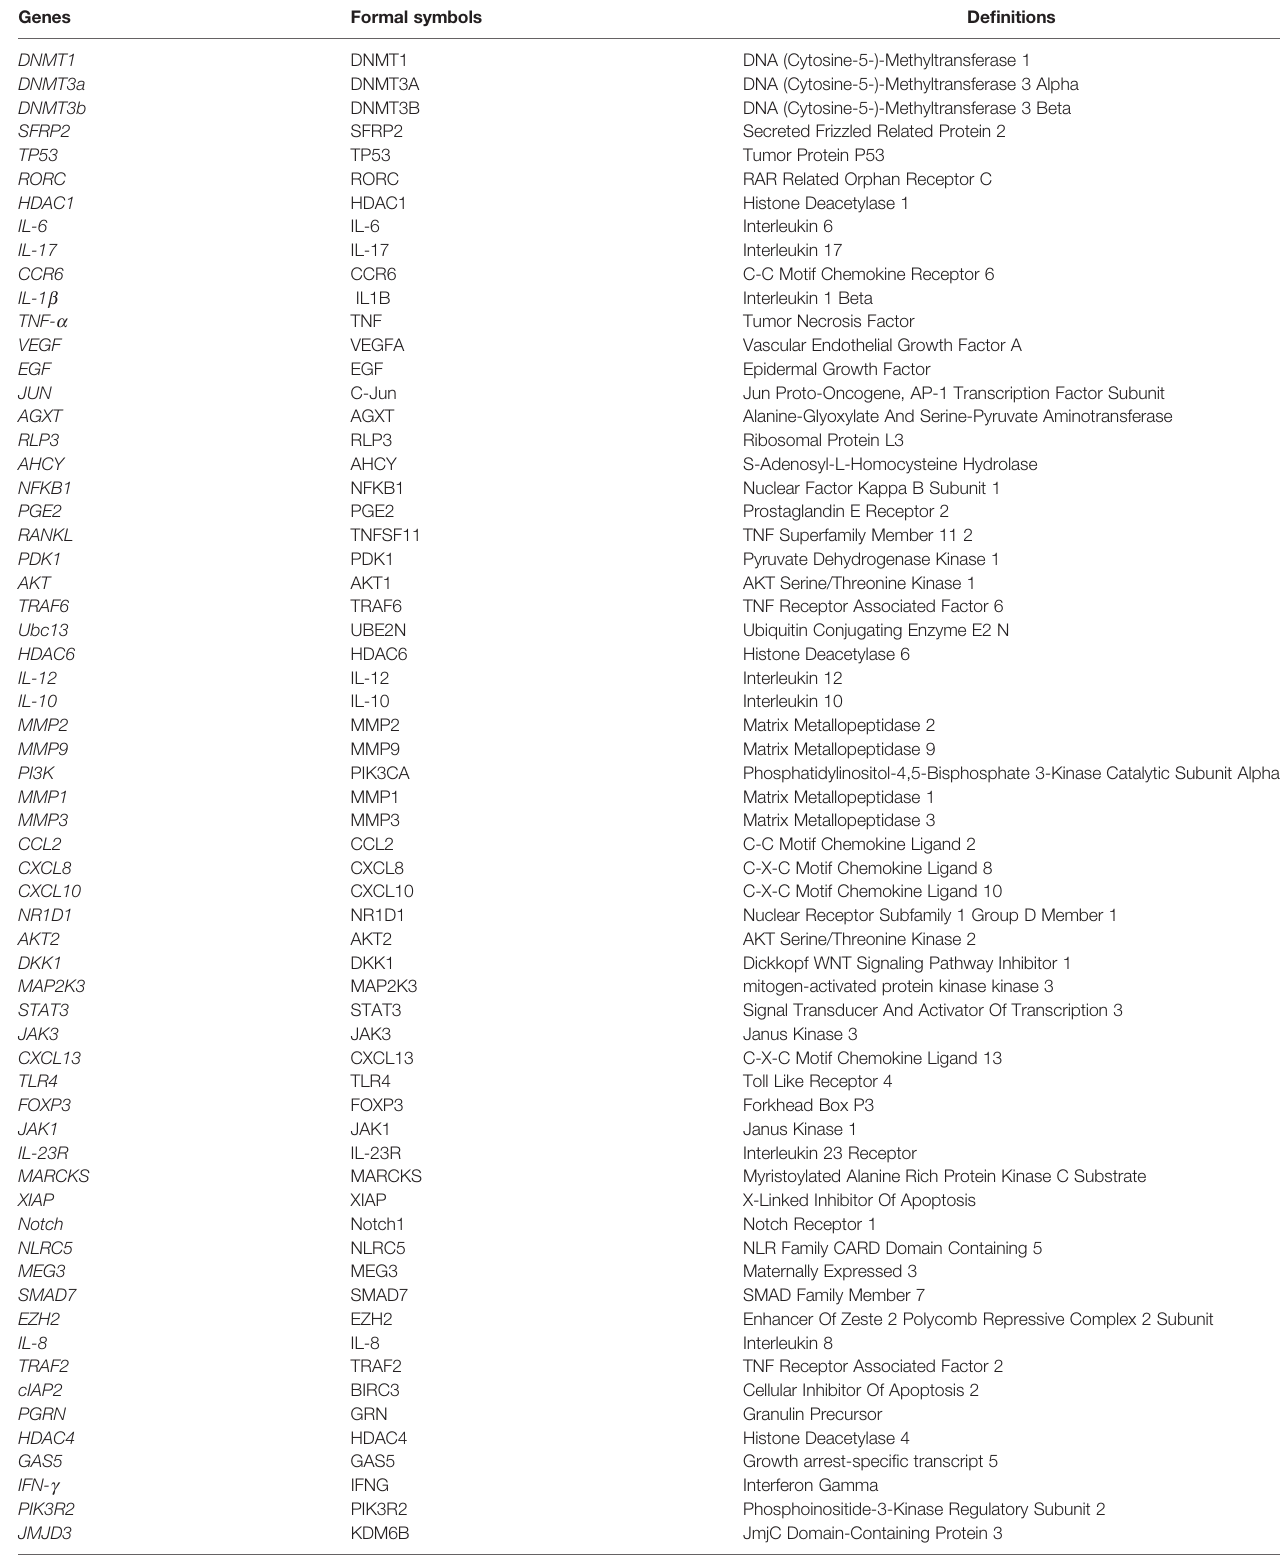
TABLE 2 | The glossary of all genes and formal symbols is mentioned in this